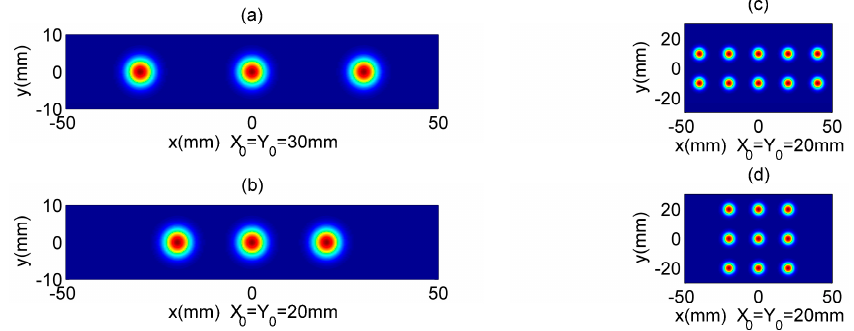
× D MGSM array beam at the plane z = 0. ( a ) N = 3, D = 1, Figure 1. The contour graphs of N D × MGSM array beam at the plane z = 0. ( a ) Figure 1. The contour graphs of N ( b ) N = 3, D = 1, ( c ) N = 5, D = 2, and ( d ) N = 3, D =